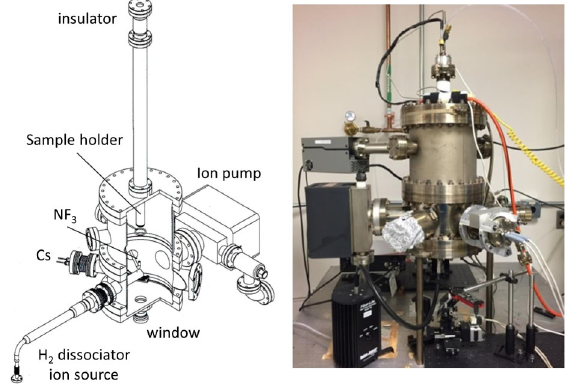
FIG. 4. Schematic representation of the ultrahigh vacuum test apparatus (left) and a photograph of the apparatus (right).